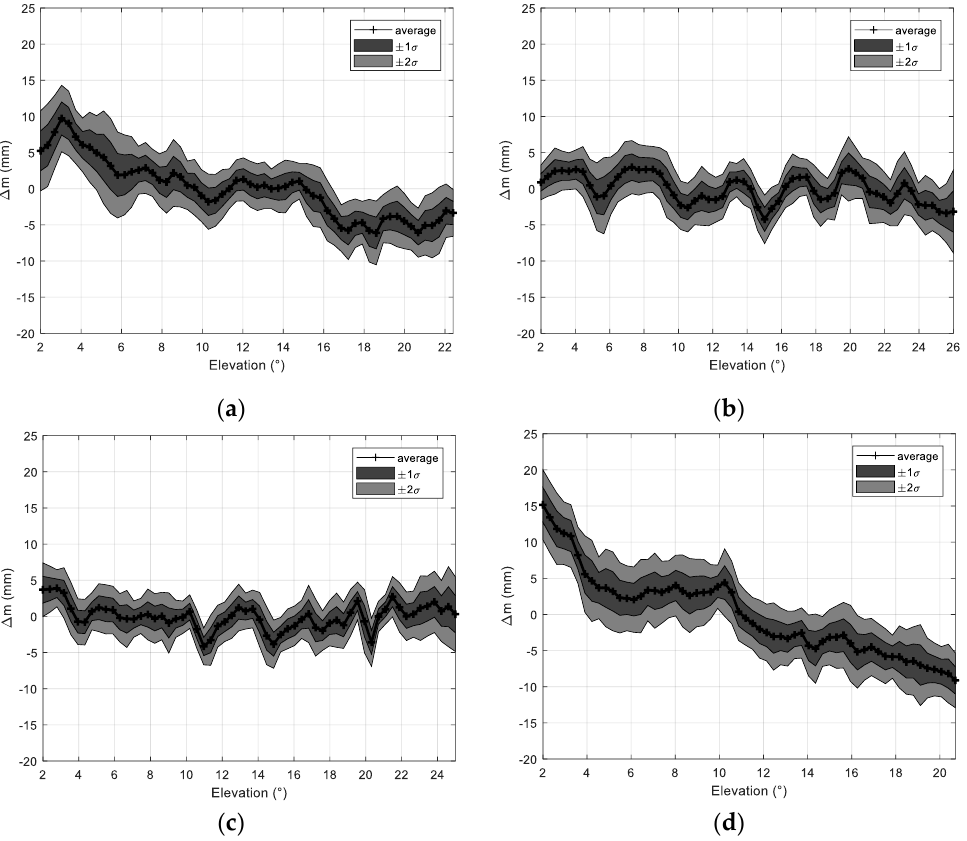
Figure 14. Statistical characteristics of four GPS satellite data in all no-rain days: ( a ) G1; ( b ) G12; ( c ) G22; ( d ) G27.